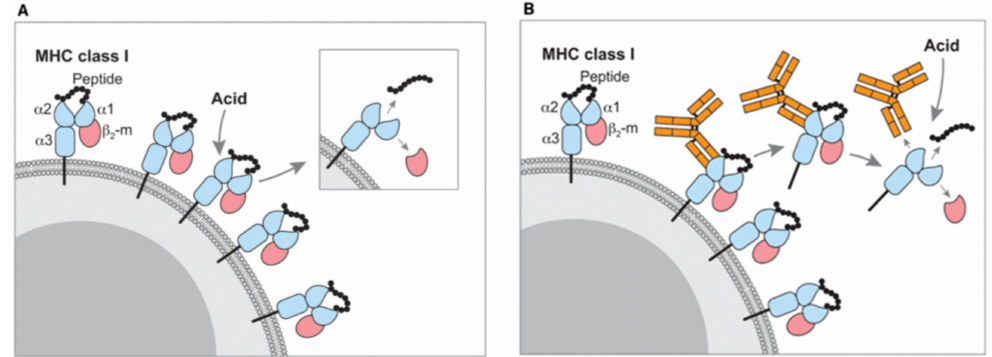
Figure 1. Methods for major histocompatibility complex (MHC) peptide isolation. ( A ) Acid wash and ( B ) immunoprecipitation (IP)-based purification. Reprinted with permission from Schumacher